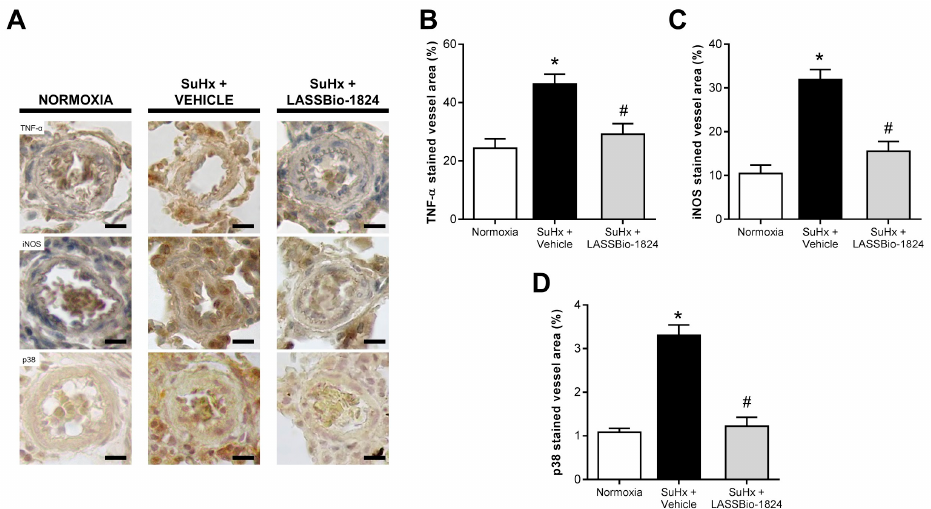
Figure 5. Effect of LASSBio-1824 on lung vasculature content of tissue-inflammation mediators in SuHx. ( A ) Representative micrographs of TNF- α , iNOS and total p38 immunohistochemistry. Bars represent 20 μ m. ( B ) Brown-stained wall area of pulmonary vessels corresponding to detected TNF- α ( n = 5 rats per group). ( C ) Brown-stained wall area of pulmonary vessels corresponding to detected iNOS ( n = 5 rats per group). ( D ), Brown-stained wall area of pulmonary vessels corresponding to detected total p38 ( n = 5 rats per group). iNOS, inducible nitric oxide synthase; TNF, tumor necrosis factor. * p < 0.05 compared to normoxia. # p < 0.05 compared to SuHx + Vehicle. Furthermore, the increase in TNF- α and iNOS was reinforced by using Western blot analysis, and exacerbated activation of p38 and caspase 3 was observed in RV homoge- nates from vehicle-treated SuHx animals ( p < 0.05; Figure 6A–B). LASSBio-1824 normal- ized the expression of inflammatory markers and caspase activation, matching the reduc- tion seen in p38 phosphorylation (Figure 6A–B). Immunohistochemical staining displayed intense nuclear localization of c-fos in RV from SuHx + vehicle rats, possibly in response to higher cardiomyocyte stress ( p < 0.05; Figure 6C,D) which was attenuated by LASSBio- 1824. The reduction in the activity of this transcription factor in RV myocytes indicates possible inhibition of the early gene program and consequent cell dysfunction and apop- tosis ( p < 0.05; Figure 6C,D).